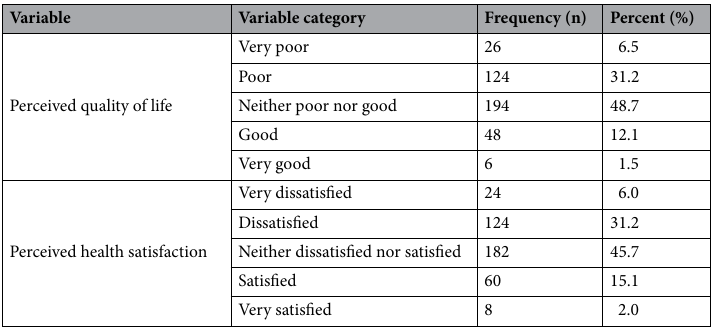
Table 5. Self-rated perceived quality of life and health satisfaction among family caregivers of patients with mental illness at DRH, Ethiopia (n = 398).